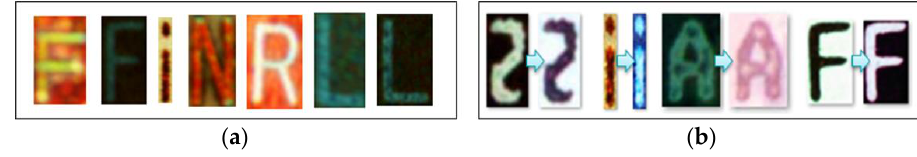
Figure 6. ( a ) Data in various colors, ( b ) Result of color reversal.